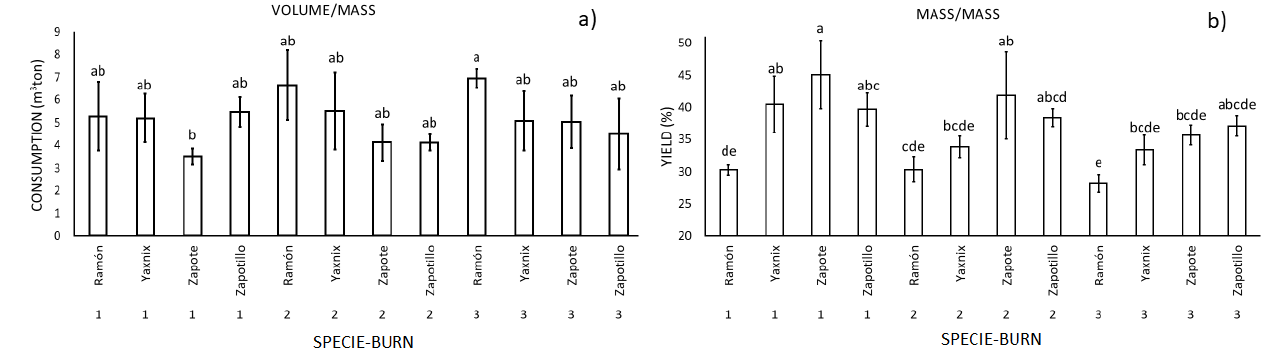
Figure 12. ( a ) Firewood consumption and ( b ) charcoal production yield in industrial metal kilns. Values with the same letter are statistically equal, according to Tukey test ( p ≥ 0.05).